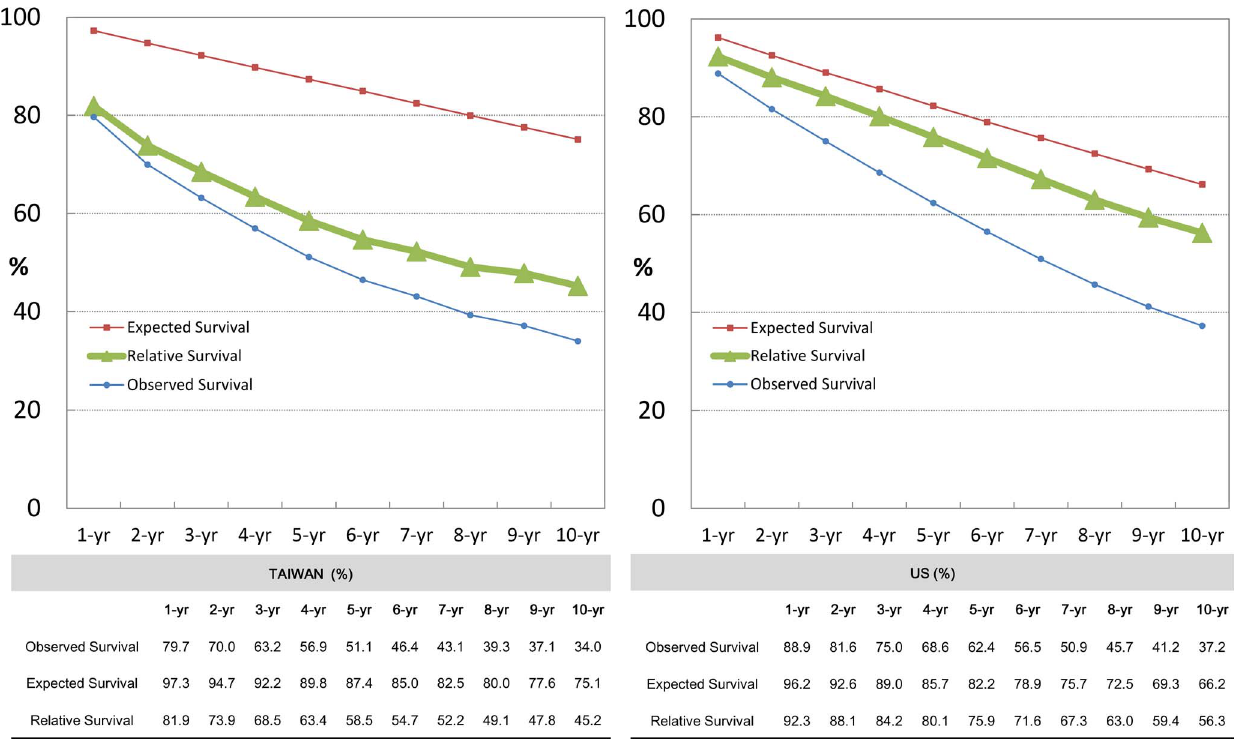
Figure 1. The estimates of observed and relative survivals of patients with CLL among Taiwanese and US patients.